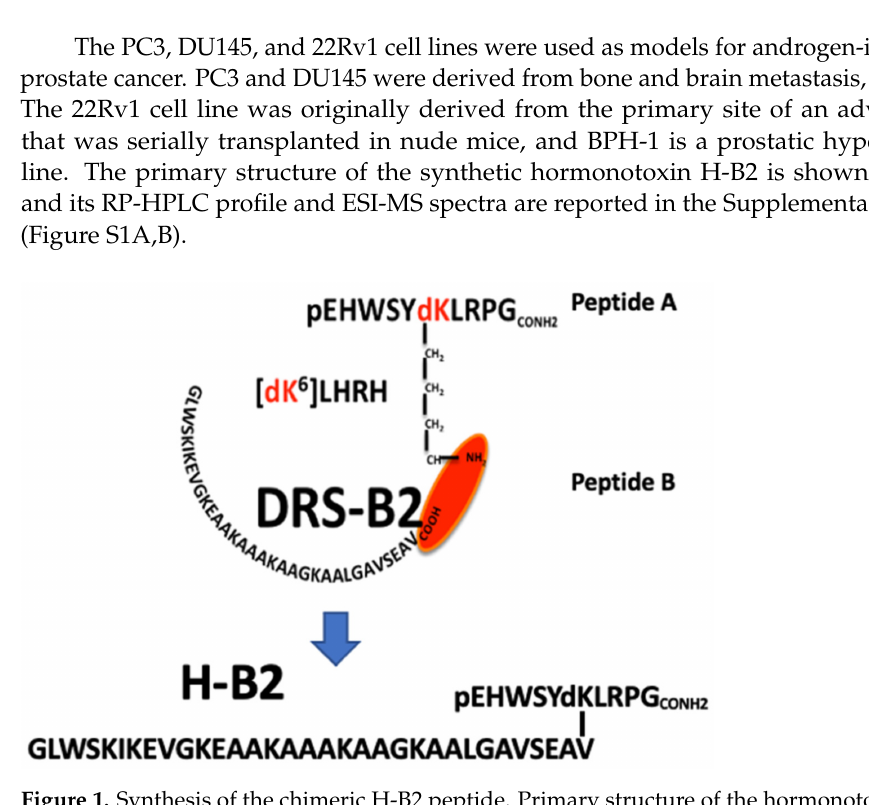
Figure 1. Synthesis of the chimeric H-B2 peptide. Primary structure of the hormonotoxin [D-Lys 6 ]- LHRH-dermaseptin B2 (H-B2). The amino acid sequence of dermaseptin B2 is represented as peptide B and the amino sequence of the LHRH analog with a D-Lys (dK) in position 6 is represented as peptide